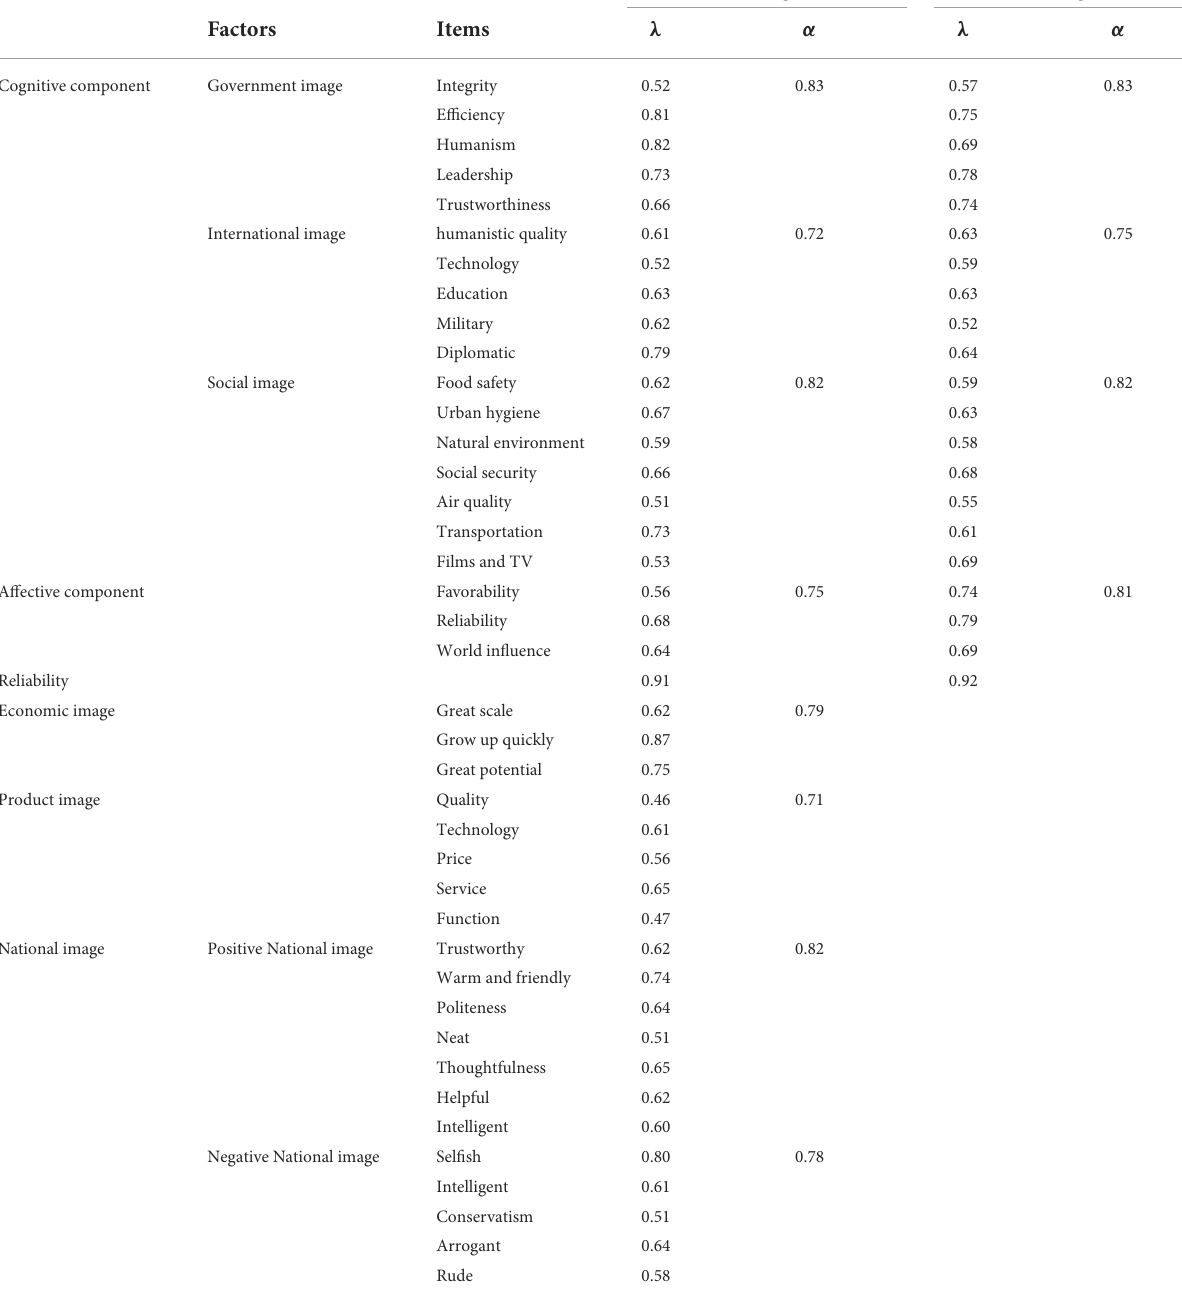
TABLE 1 The items loadings ( λ ) and coefficients ( α ) of measurement models. Scales Before coming to China After coming to China Factors Items λ α λ α Cognitive